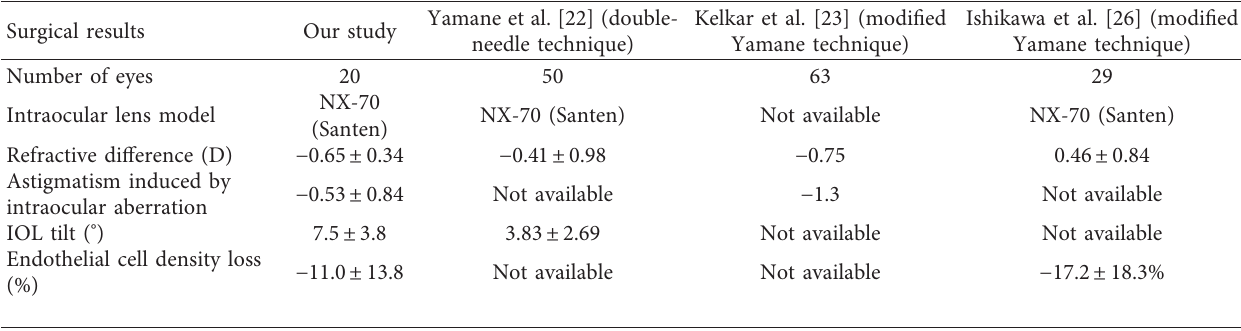
Table 2: Comparison of surgical results with other techniques of intrascleral fixation of intraocular lens. Surgical results